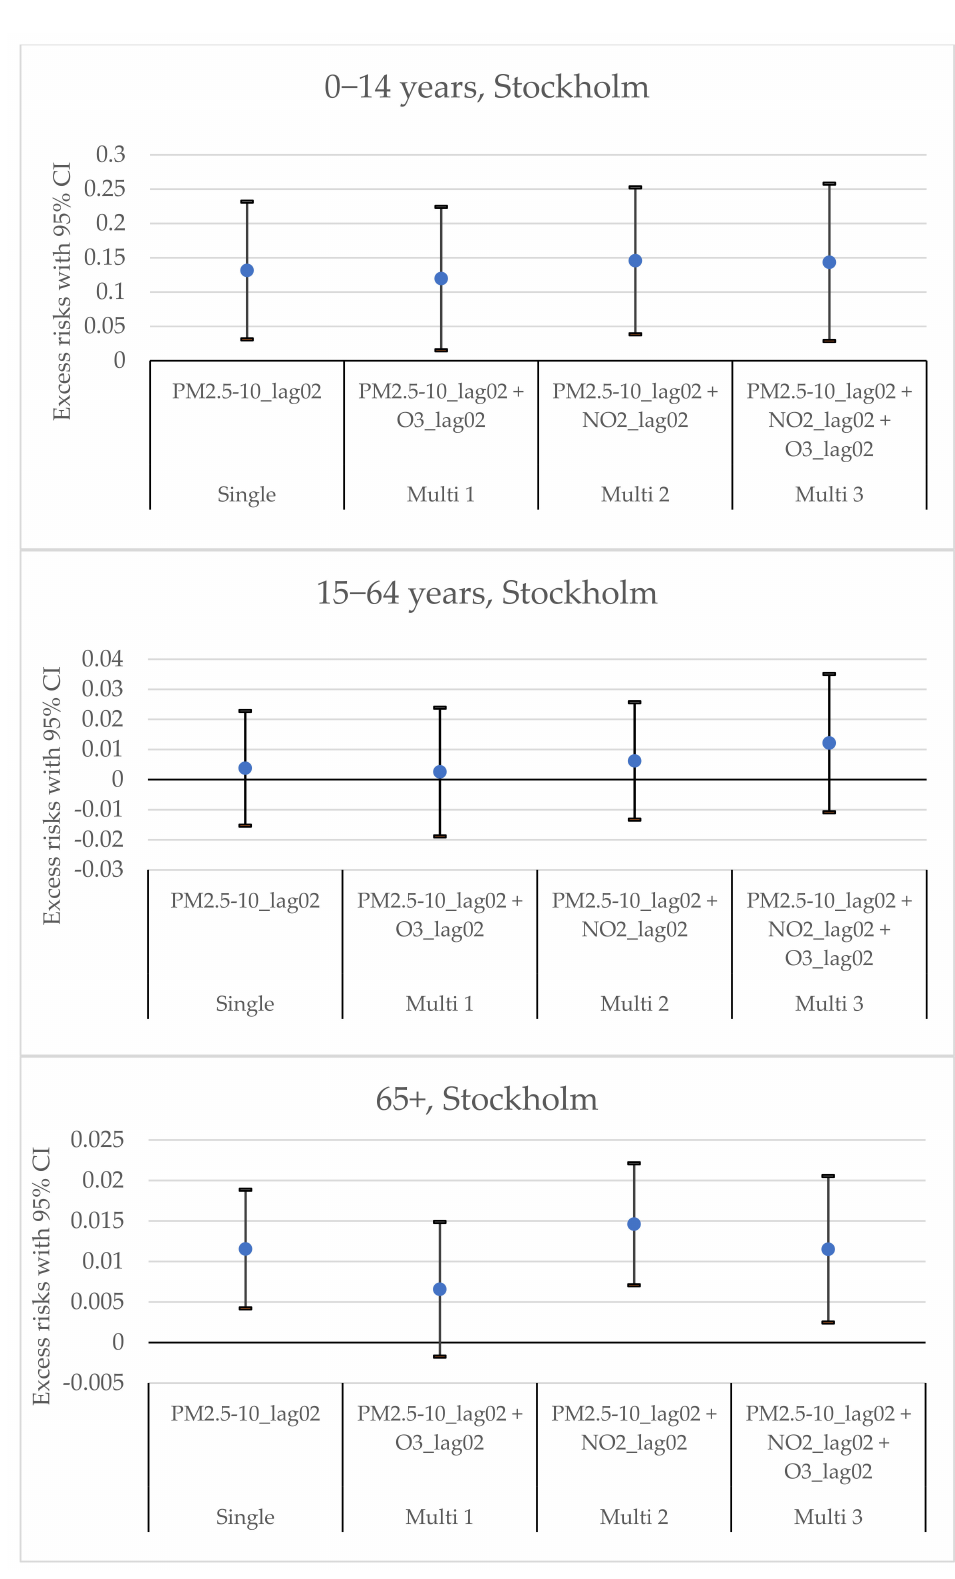
Figure 3. Multi-pollutant models of the estimated change in daily mortality in different age groups (with 95% CI) for an IQR increase in the concentration of PM 2.5–10 (lag02) in Stockholm. From left to right: a single-pollutant estimate of PM 2.5–10 (Single), PM 2.5–10 adjusted for O 3 (Multi 1), PM 2.5–10 adjusted for NO 2 (Multi 2), and PM 2.5–10 adjusted for both NO 2 and O 3 (Multi